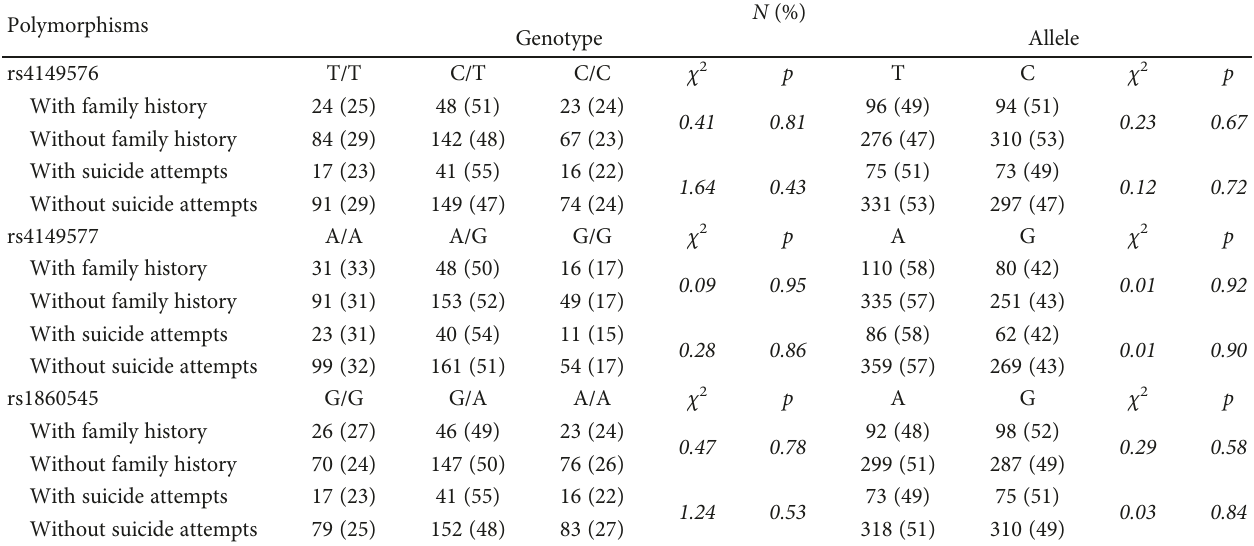
Table 2: Genotype and allele distributions for the TNFR1 (rs4149576, rs4149577, and rs1860545) SNPs in patients with and without family history of schizophrenia and suicide attempts.